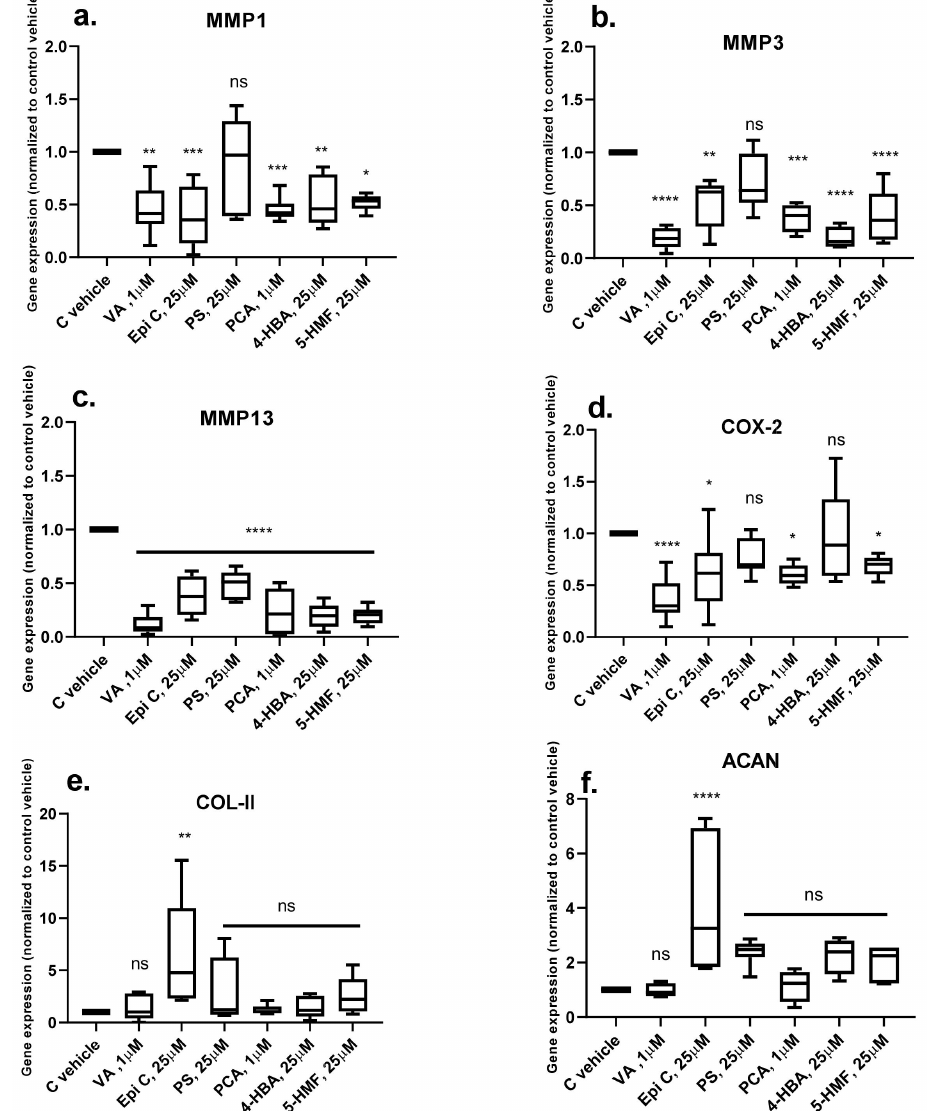
Figure 2. Transcriptional level of catabolic genes matrix metalloproteinase (MMP) a ) MMP1 b )